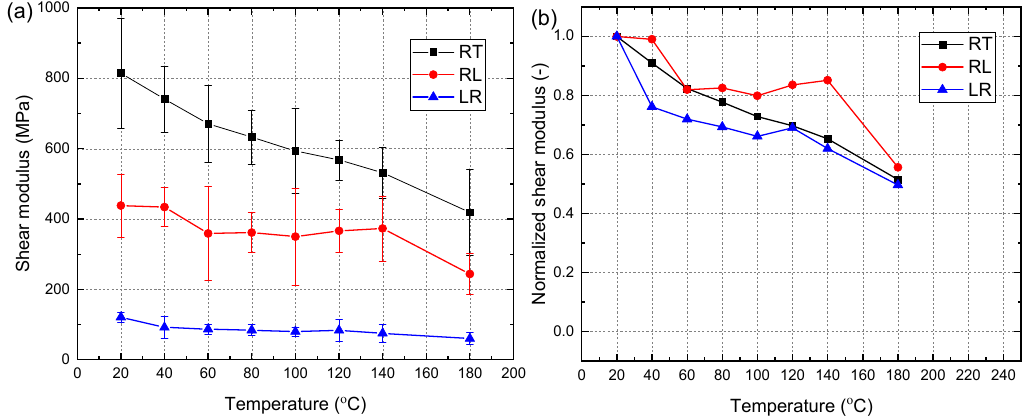
Figure 7. Shear modulus of specimens: ( a ) Shear modulus; ( b ) Normalized shear modulus.